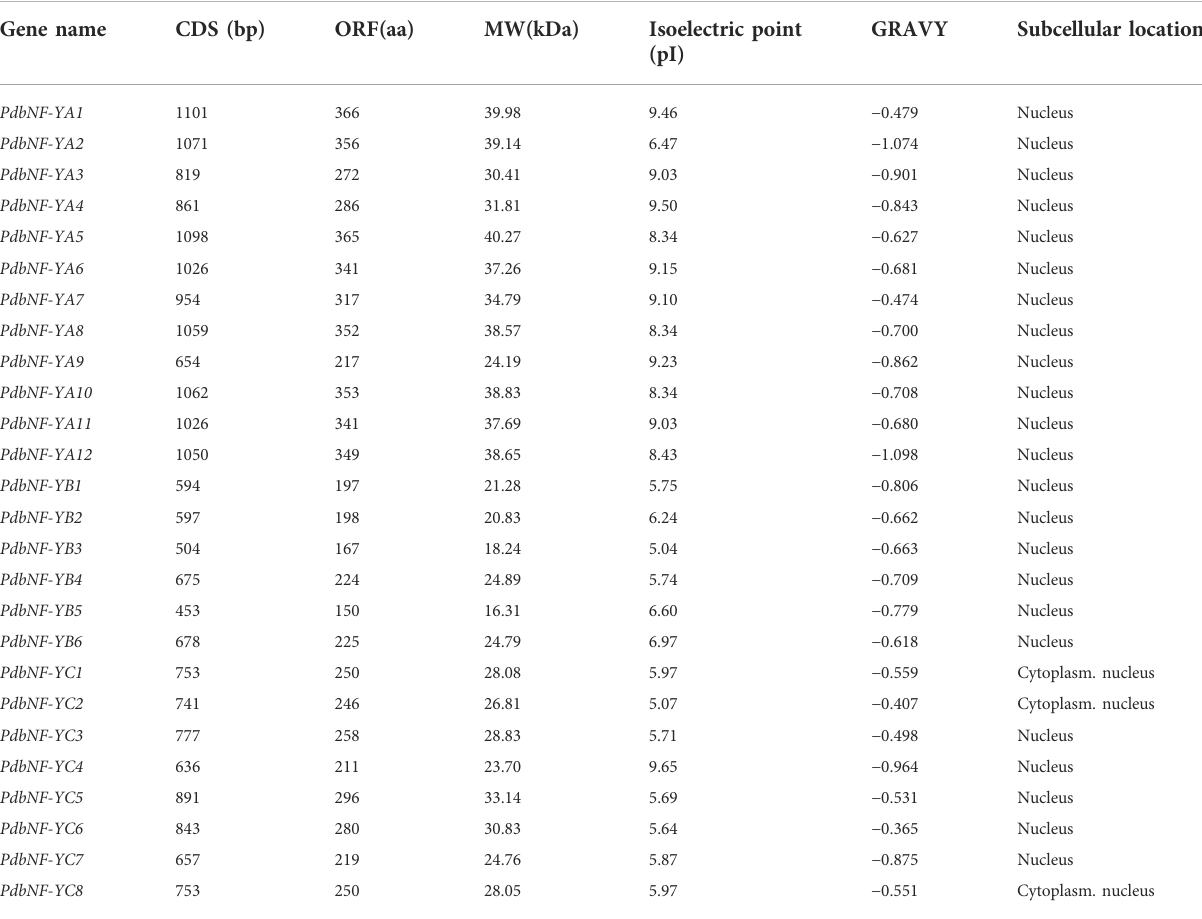
TABLE 1 Characteristics of PdbNF-Y s in